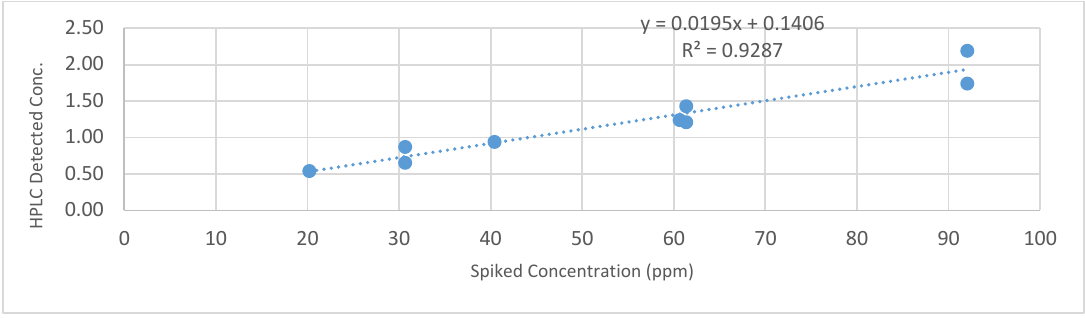
Figure 6. Correlations of LC-MS/MS measured and spiked tylosin concentrations.